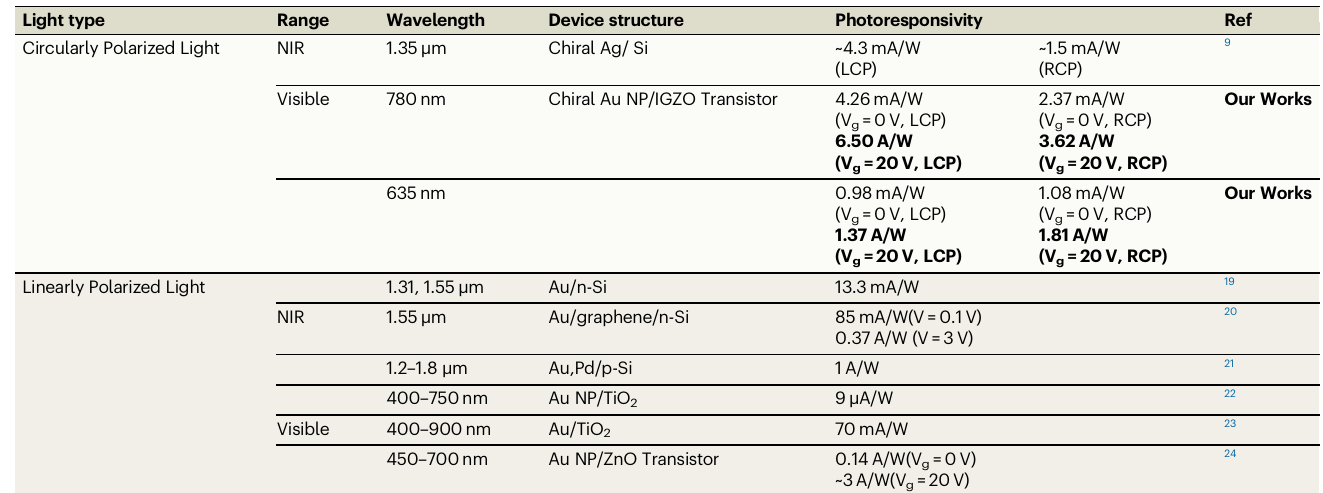
Table 1 | Previously reported hot electron-based photodetectors Light type Ref Circularly Polarized Light